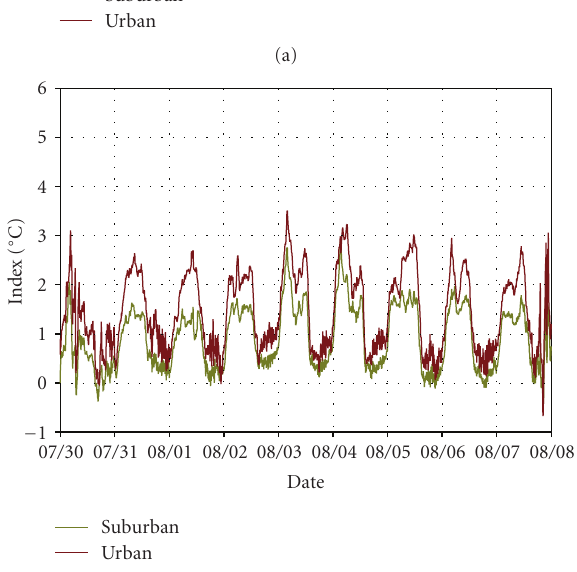
Figure 2: (a) Composite urban (red), suburban (gold), and rural (blue) values of air temperature from 30 July 2008 to 8 August 2008. (b) Composite diurnal values of urban heat island intensity with respect to rural composite values for the urban (red) and suburban (gold)